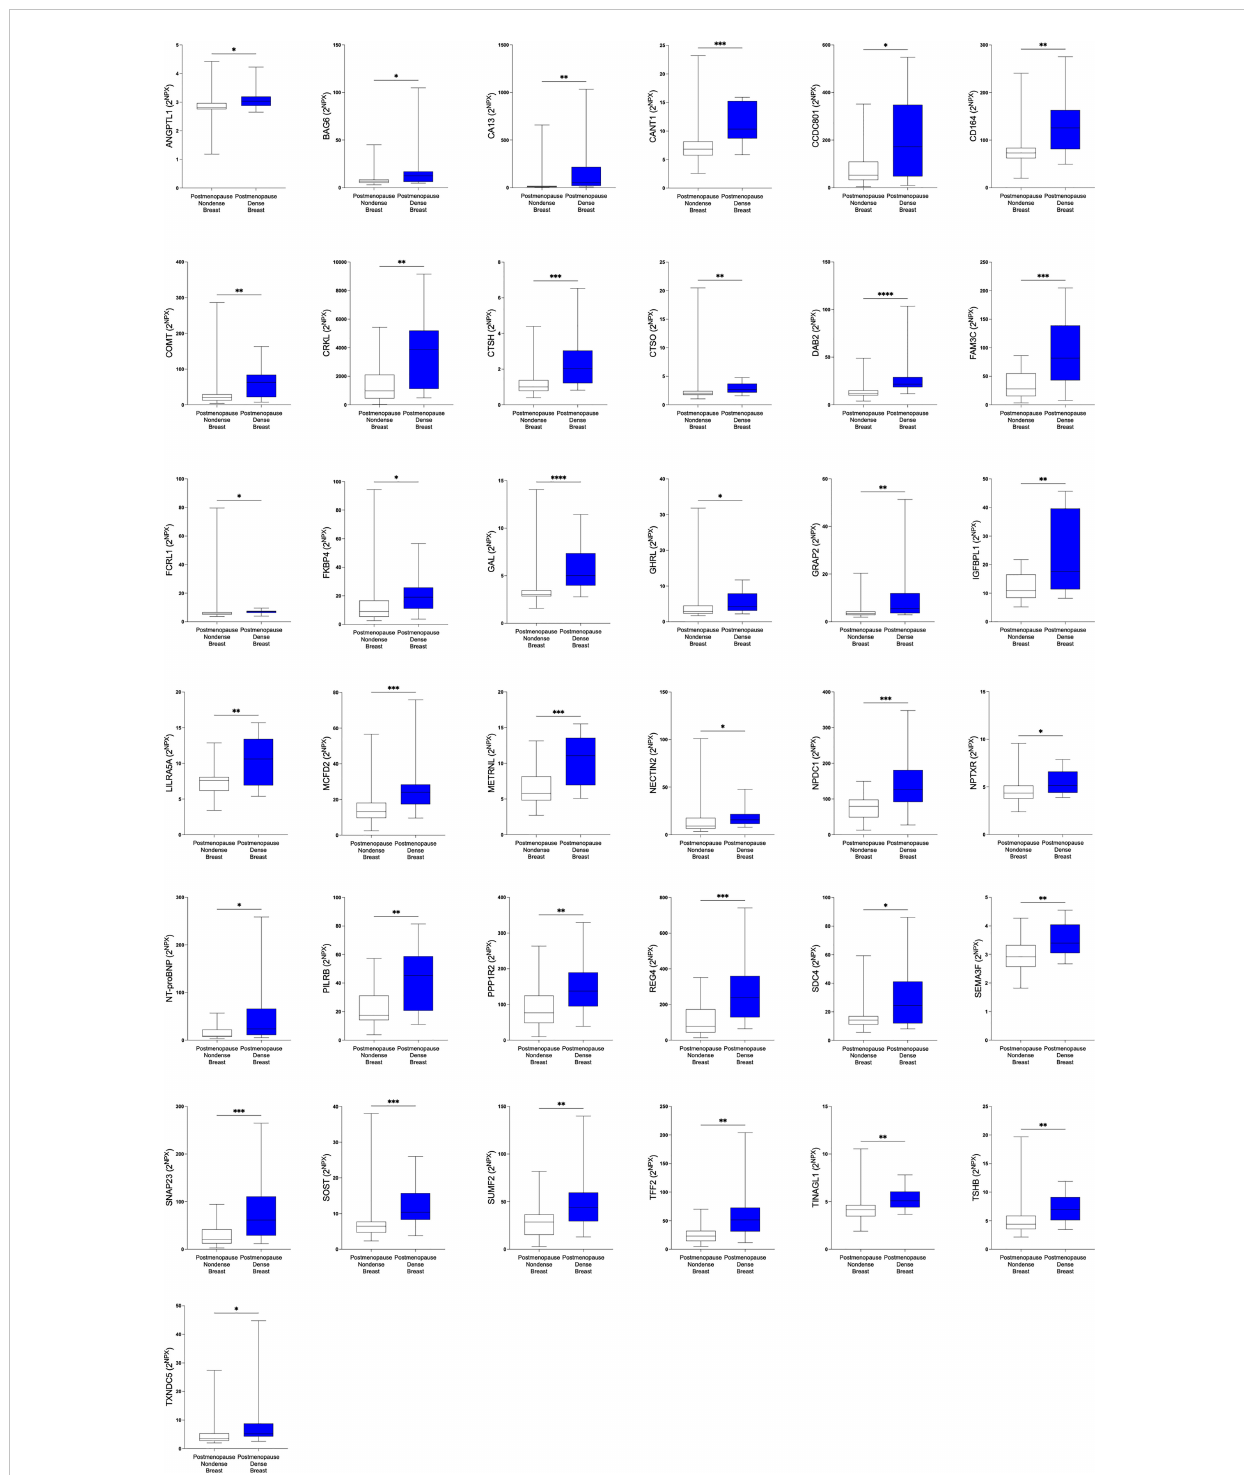
FIGURE 3 Signi fi cantly altered extracellular levels of proteins regulating metabolism in postmenopausal dense and nondense breast tissue. 40 healthy postmenopausal women with dense breast tissue (n=20) or nondense breast tissue (n=20) were subjected to microdialysis in the upper lateral quadrant of the left breast for in vivo collection of proteins from the extracellular space. The levels of the signi fi cantly altered proteins that were depicted in Figure 1B are shown. Data are presented as box plots with whiskers of min and max values. * P <0.05, ** P <0.01, *** P